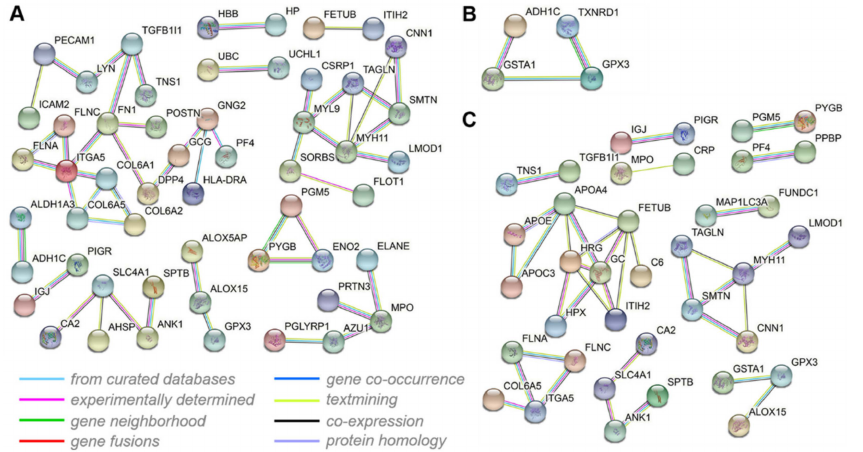
Figure 12. The Protein-protein interaction (PPI) networks of DEPs in three comparisons: L vs. M ( A ), M vs. H ( B ), and L vs. H ( C ). Nodes represent proteins, and lines of different colors represent the predicted different associations.